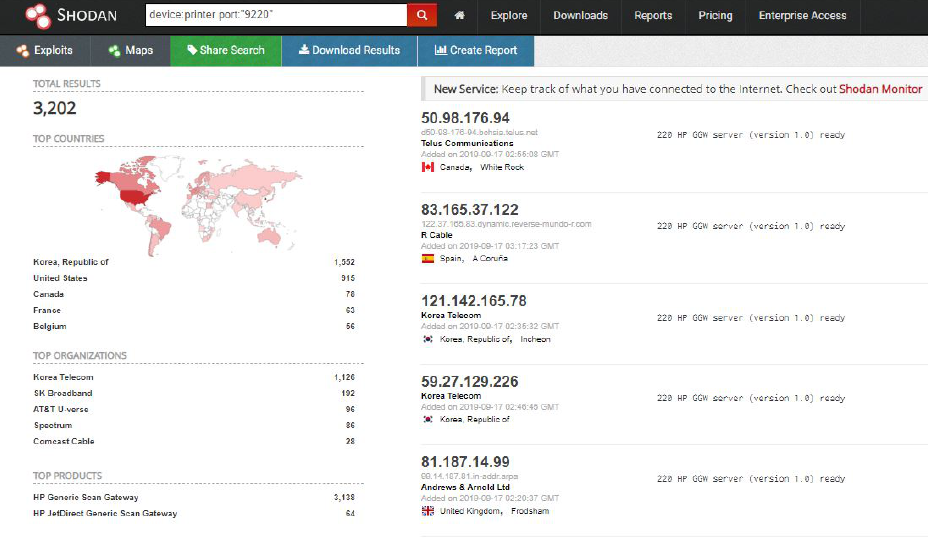
Figure 4. Identifying vulnerable printers on